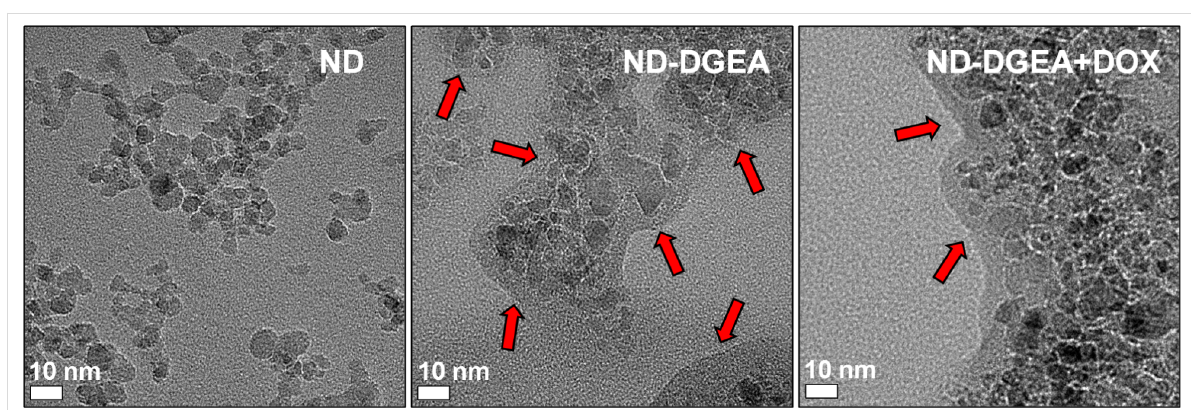
Figure 2: Transmission electron microscope images of ND, ND-DGEA, and ND-DGEA+DOX. Arrows identify the layer of DGEA or DGEA and DOX surrounding the NDs.